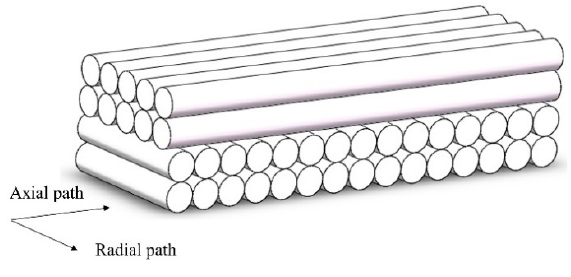
Figure 18. The path direction.